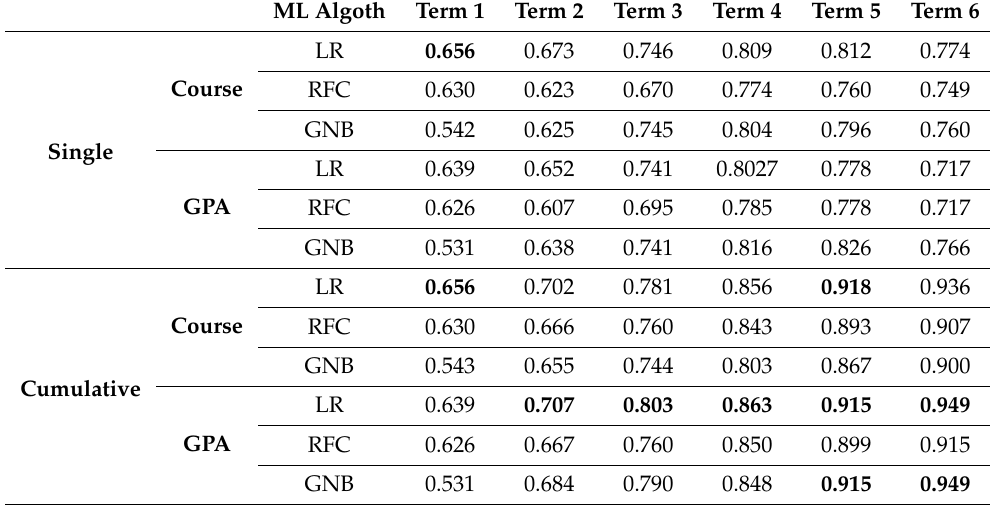
Table 6. Accuracy results of the ML Models only with the academic